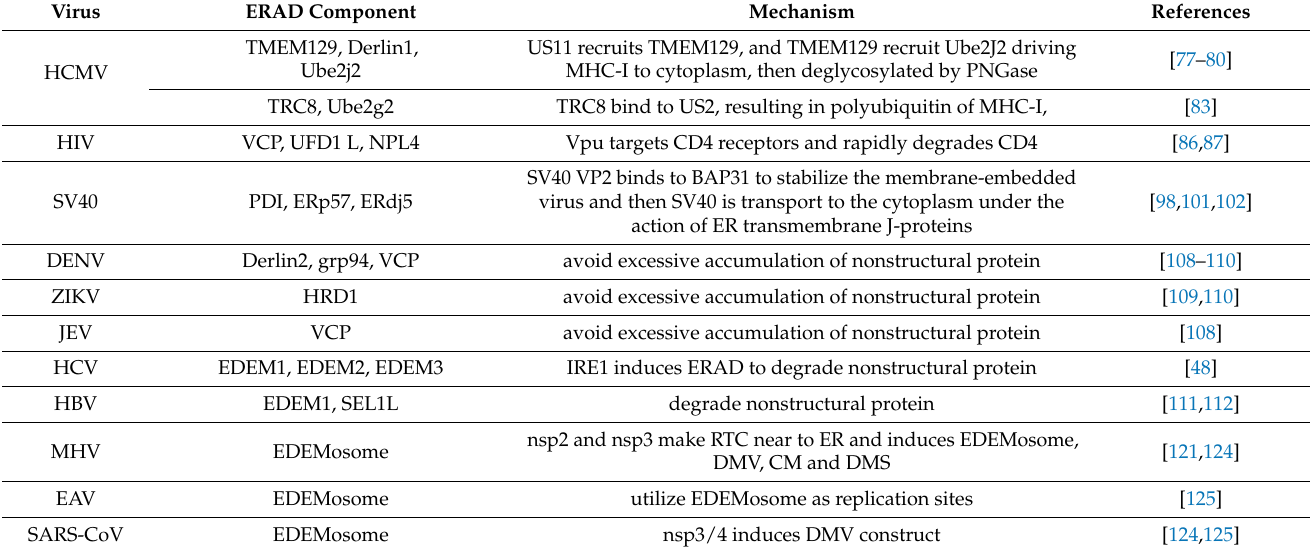
Table 2. Mechanism by which viruses hijack